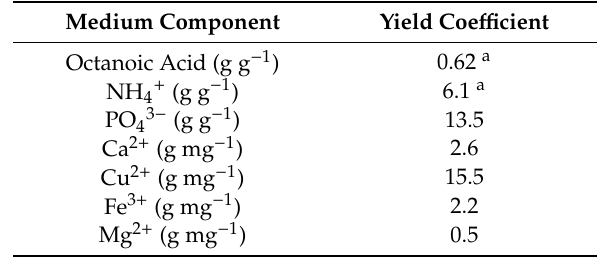
Table 1. Yield coe ffi cients for C, N, P, and certain (detectable) trace elements.